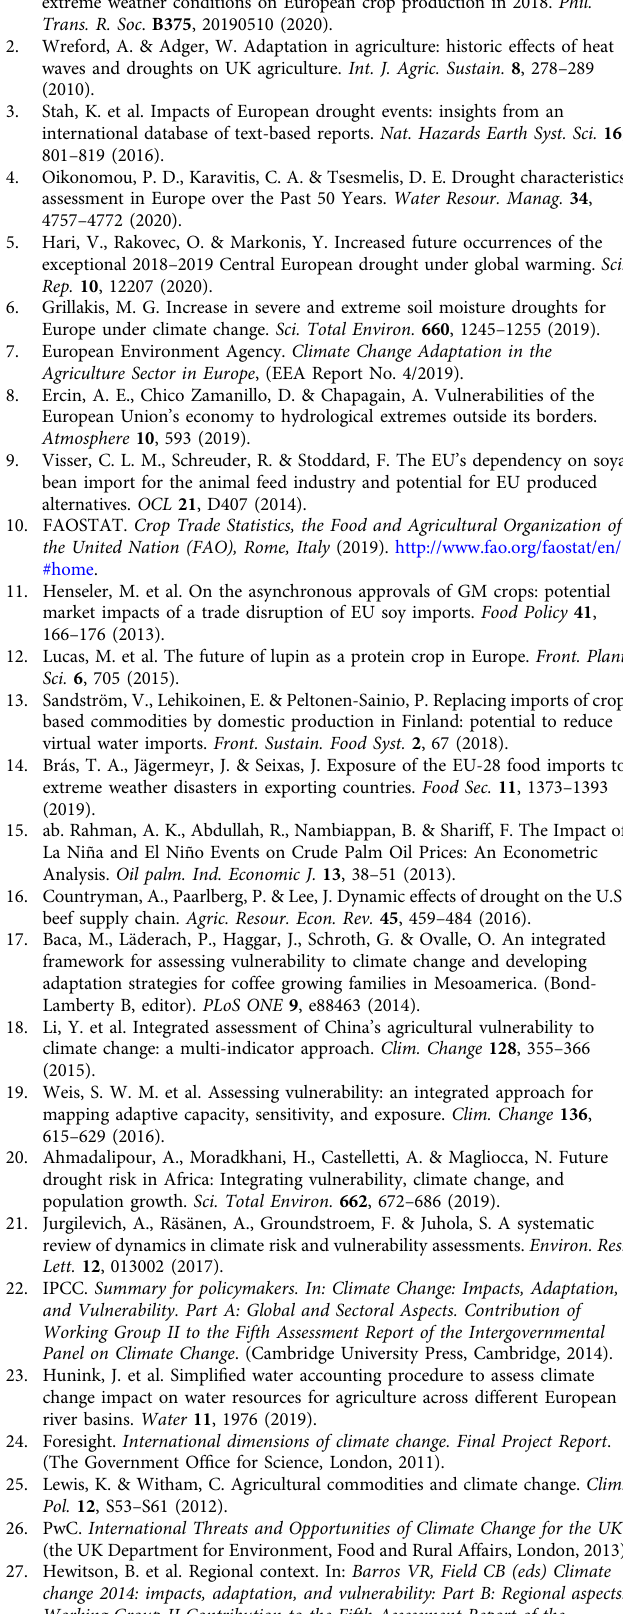
Table 2 Climate vulnerability scores and corresponding vulnerability